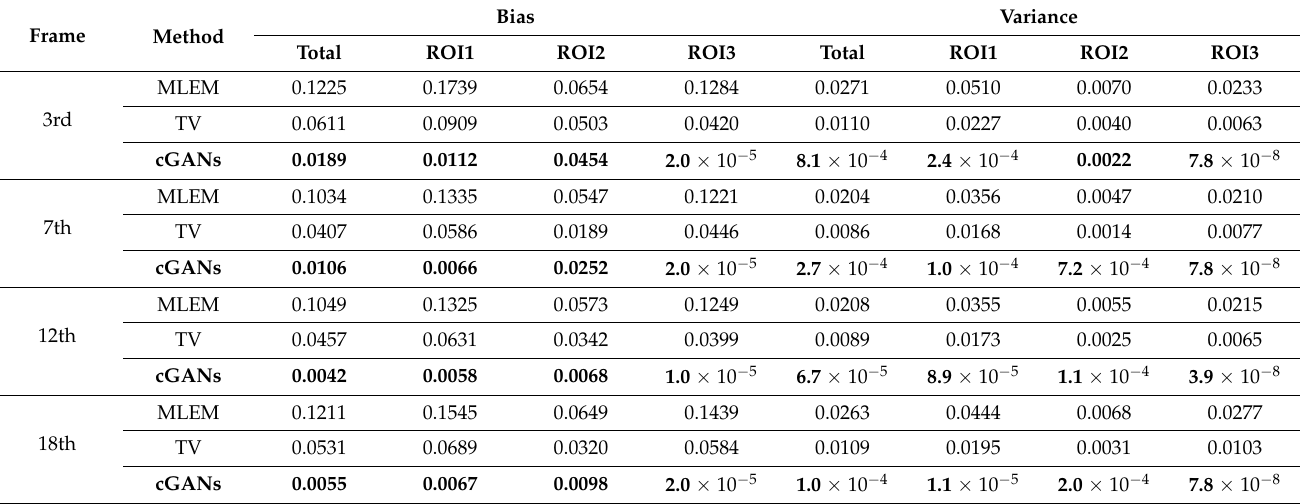
Table 2. Zubal thorax reconstruction evaluation results.